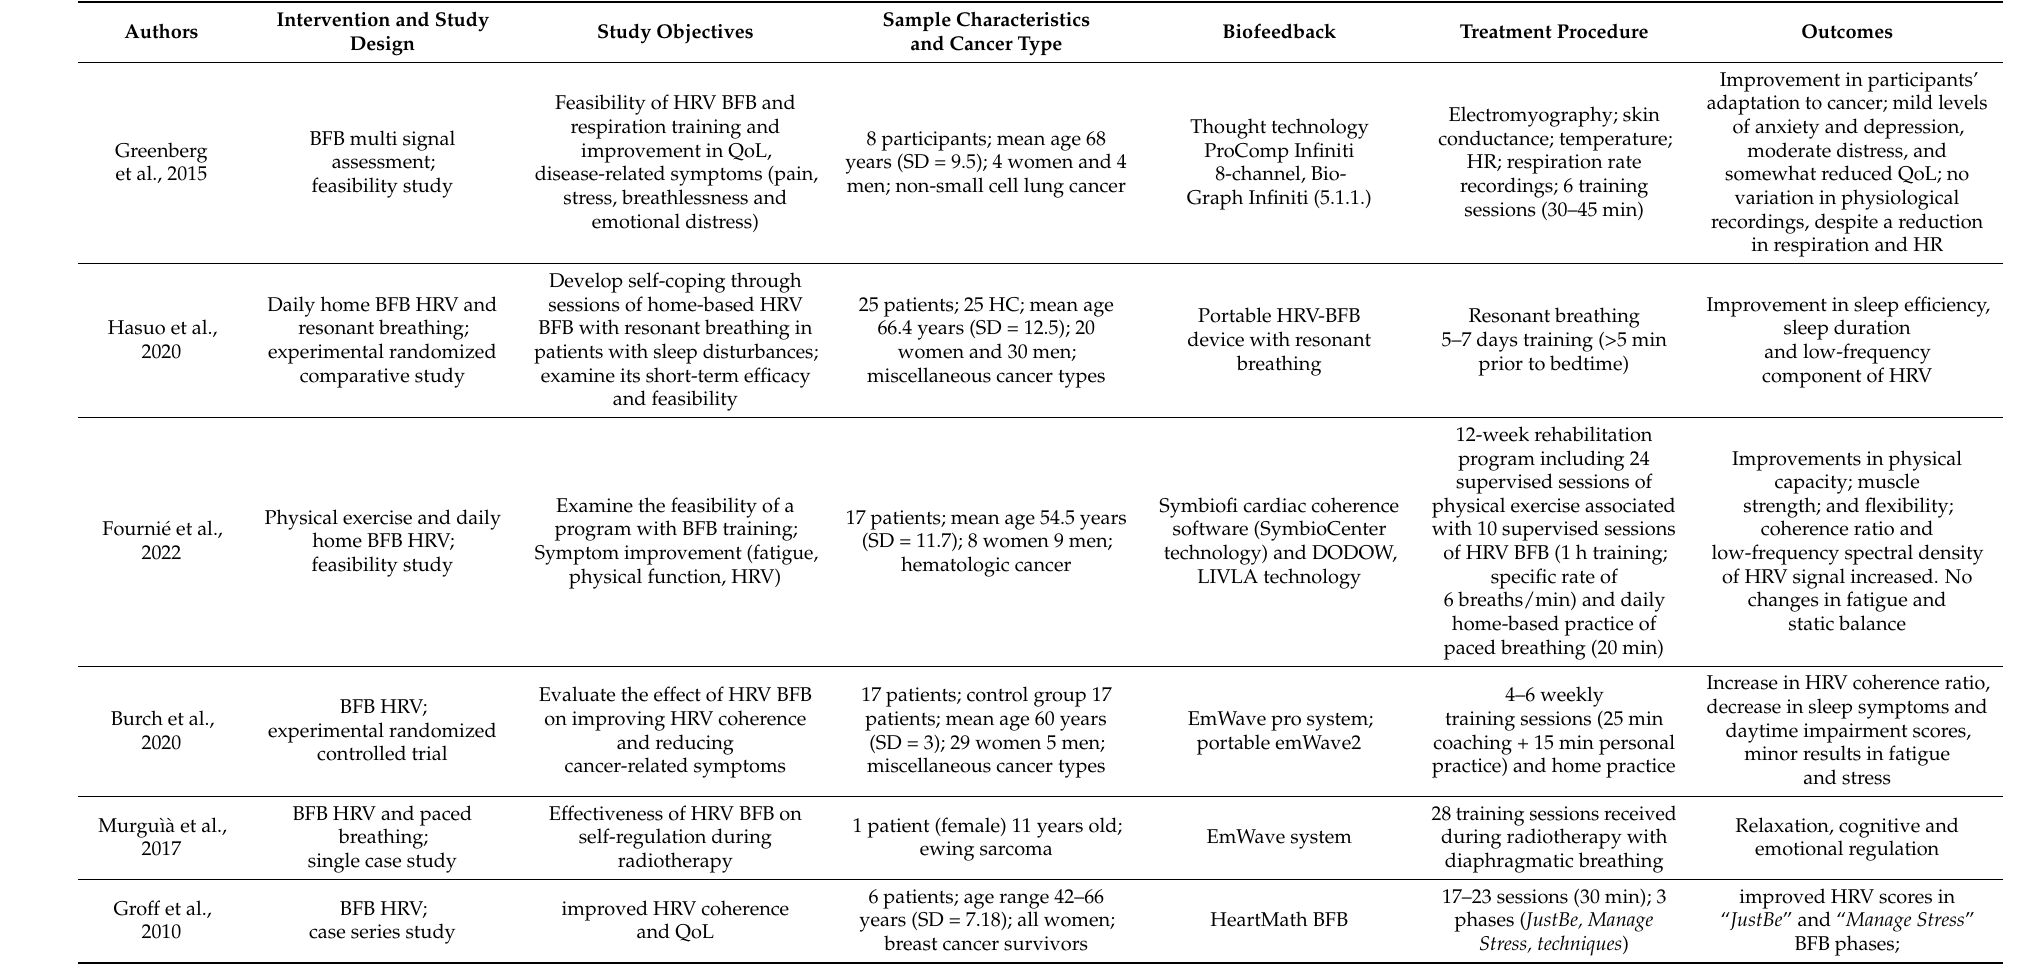
Table 1. Empirical original research studies characteristics and